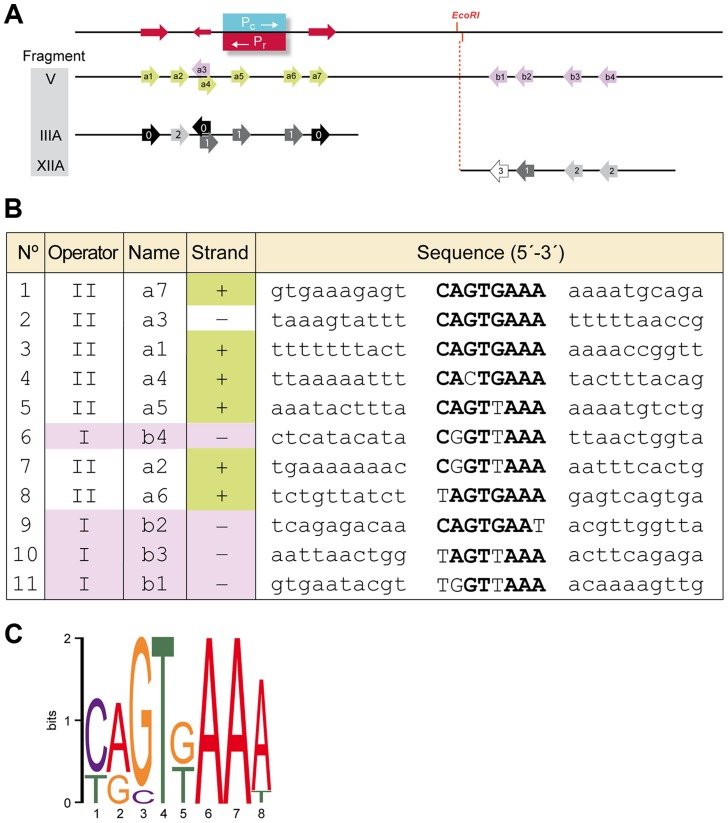
Identification of a conserved motif constituting (part of) the RcoLS20 binding site.
A. Schematic representation of the region corresponding to Fragment V, which encompasses promoters Pr/Pc and the identified repeated motif that form (part of) the binding site for RcoLS20. Top line. Position of promoters Pc and Pr are indicated in blue and red, respectively. The position of the unique EcoRI site is indicated. A 13 bp long direct repeat (5′-TCAGTGAAAAAAA-3′) is indicated with rightward directed red arrows. The leftward-directed arrow indicates the position of the complementary 9 bp sequence 5′-TTTCACTGA-3′. Second line (Fragment V). Arrows indicate the positions of the identified motifs a1–a7 and b1–b4. Motifs present on the upper and the lower strand are shown in green and purple, respectively. Third and fourth line show identified motifs present on Fragment III_A and XII_A, respectively. Black, dark grey, grey and light grey indicate motifs identical to the consensus sequence or deviating at one, two or three positions, respectively. B. An alignment of the nucleotide sequences of the eleven identified motifs and their flanking sequences. Names according to the nomenclature in “A” are given together with information on the strand and the region. Sequences corresponding to the consensus sequence of the motif are given in bold. C. A representation of the consensus motif generated by Weblogo [73]. The size of each nucleotide corresponds to the frequency with which that nucleotide is observed in that position.